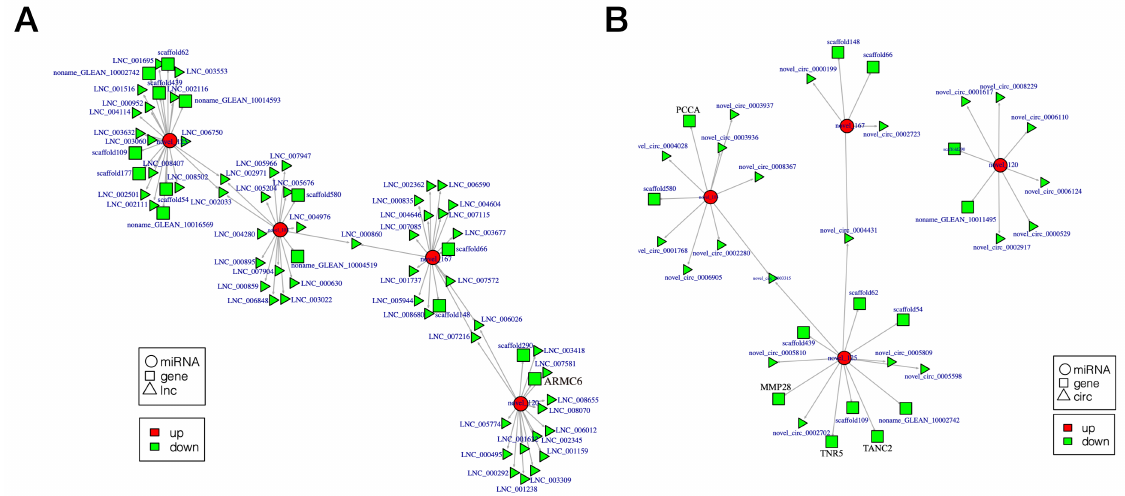
Figure 6. Competing endogenous RNA (ceRNA) network related to metabolism, immunity, and signal transduction between infertile and fertile group in Paralichthys olivaceus . ( A ) lncRNA-miRNA-gene ceRNA networks. ( B ) circRNAs-miRNA-gene ceRNA networks. Rectangle, ellipse, and triangle indicate mRNA, miRNA, and lncRNA/circRNA, respectively. Green and red indicate down-regulation and up-regulation,